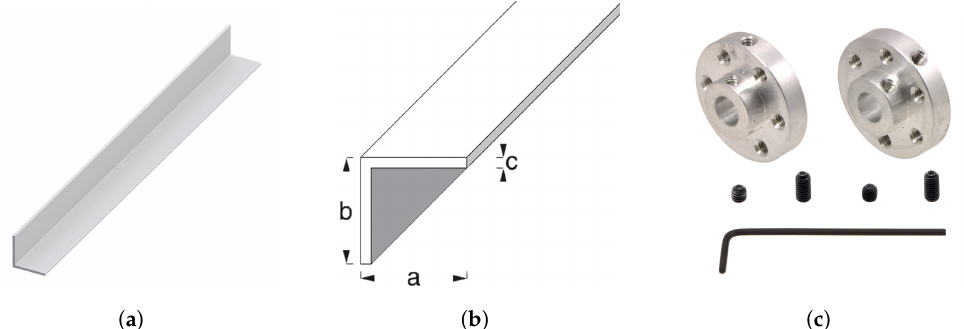
Figure 1. Representation of the dimensions of the rail and coupling used. ( a ) View of the aluminum rail used. ( b ) Measurement of the aluminum used for ball and beam, where a is equal to 2 cm, b is equal to 2 cm, and c is equal to 1 mm. ( c ) Pololu Universal Aluminum Mounting Hub for 6 mm Shaft.